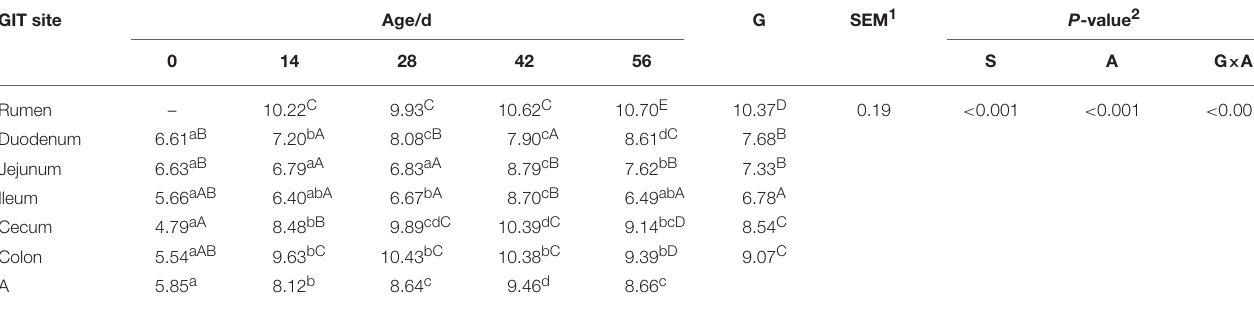
TABLE 2 | Total bacterial numbers (log 10 gene copies/g of digesta sample) attached to different GIT site from 0 to 56 d. GIT